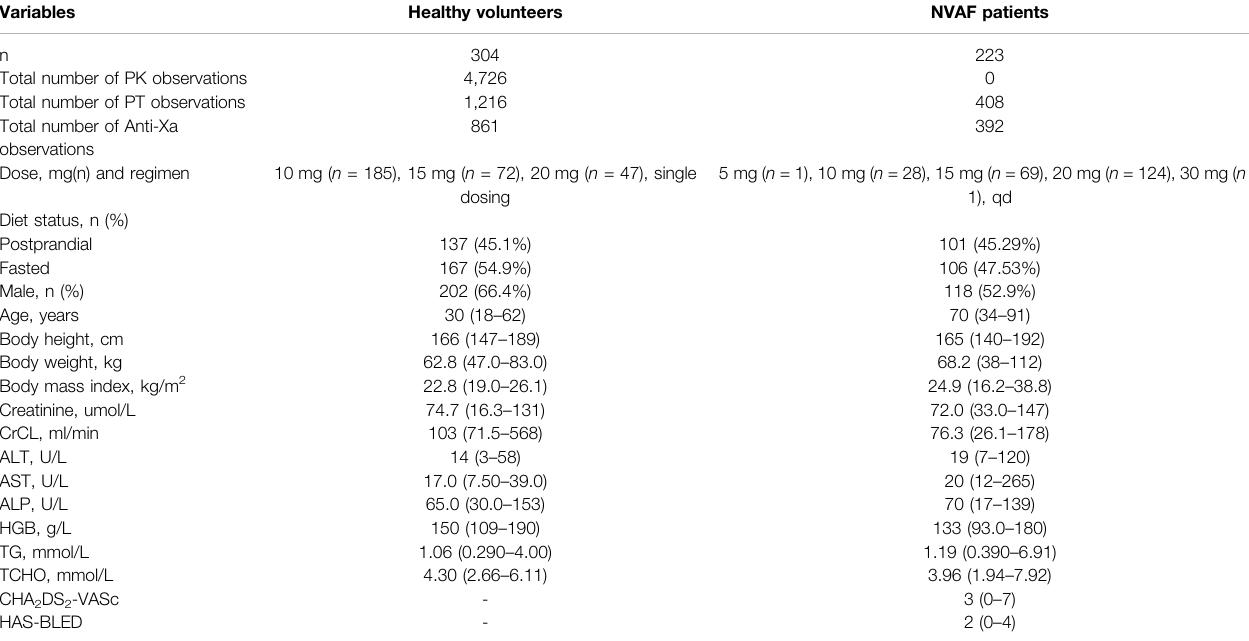
TABLE 1 | Baseline characteristics of subjects included in the